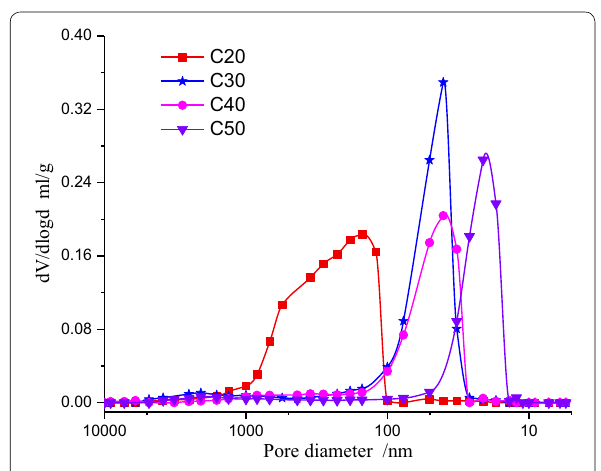
Fig. 16 Differential curve of aperture